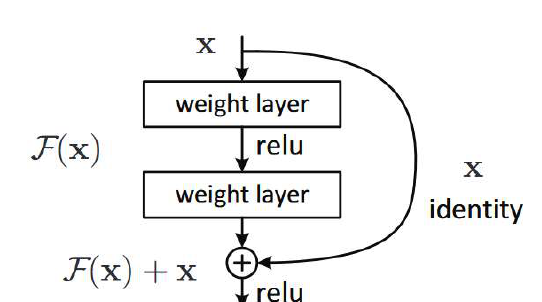
Figure 2. The Residual network learning residual functions by referring input layers (He et.al.,